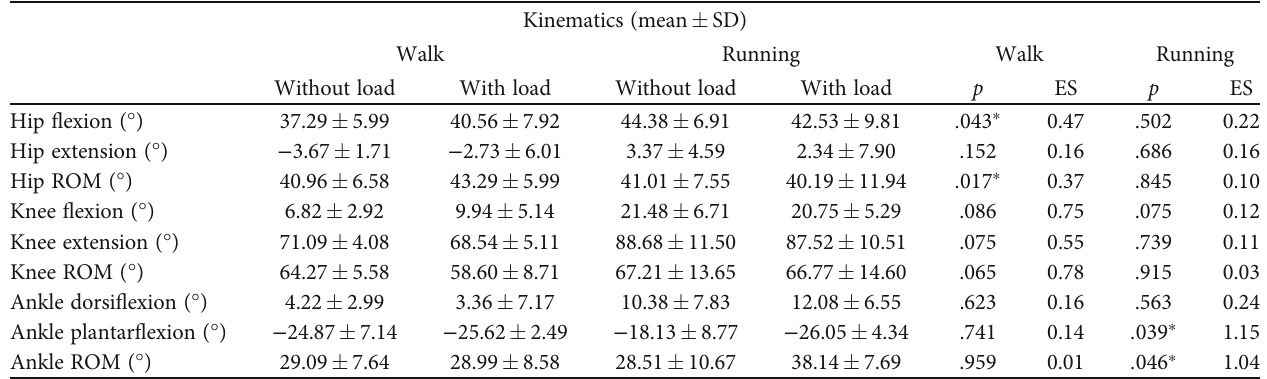
T ABLE 2: Descriptive statistics and p -values for joint kinematics with and without load carriage.